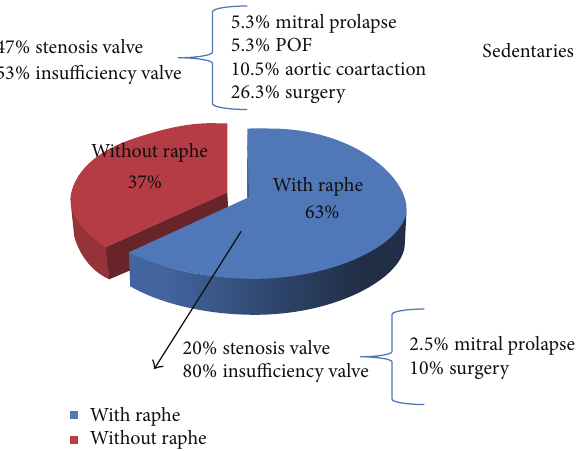
Figure 4: Presence of BAV morphologies and associated cardiac patterns in sedentaries BAV subjects. LV chamber echoparameters of athletes and sedentary subjects with different BAV morphologies.